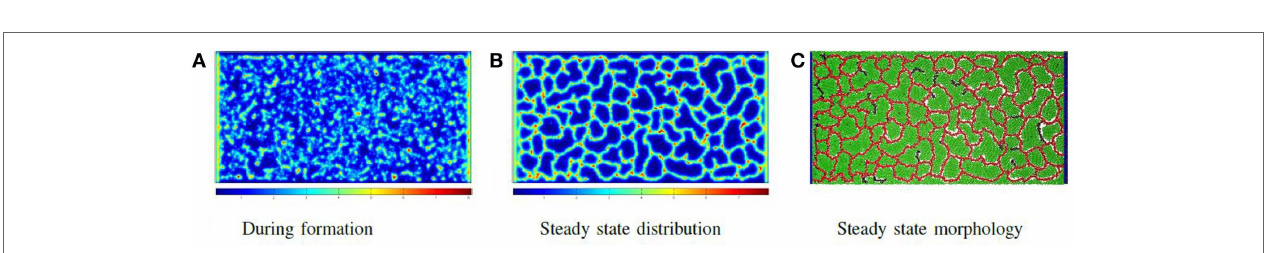
FIGURE 5 | Phase I: self-organizing the network: the distribution of chemoattractant during vessel formation and at a steady state, along with the final vessel network formed . In all images of biochemical distribution, blue signifies a low concentration, while red signifies a high concentration (A–C)